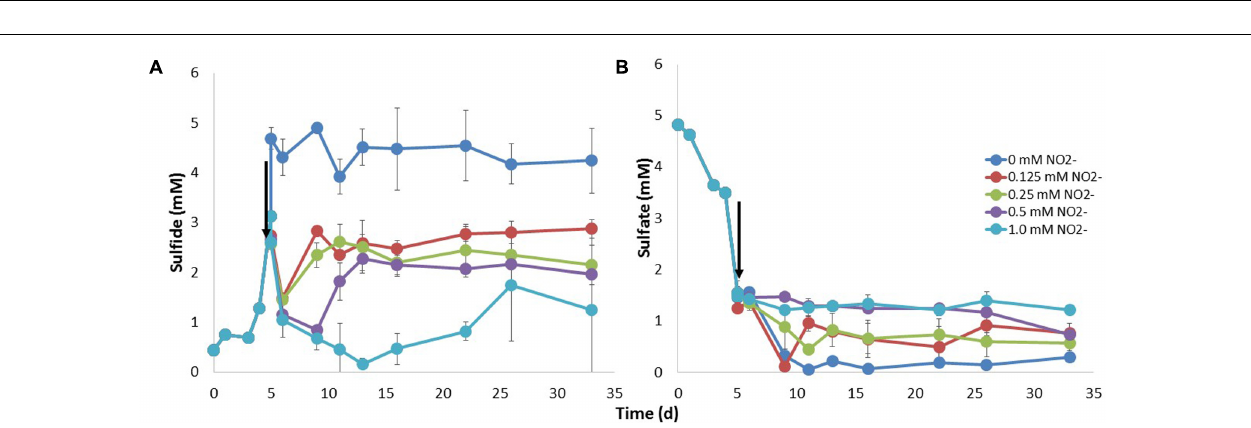
FIGURE 5 | Effect of incubation temperature on growth and sulfate reduction by tSRB consortia enriched from PW1\_14. The concentration of sulfate (A) and of sulfide (B) , as well as the cell density as OD 600 (C) are presented as a function of time. Data are averages for duplicate incubations. The medium contained 20 mM lactate and 10 mM sulfate.